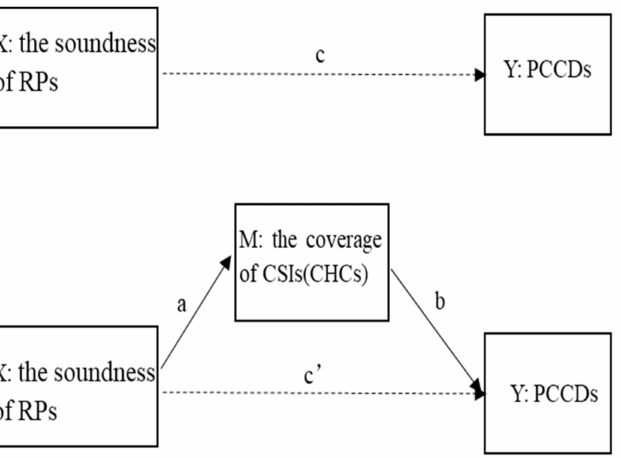
Figure 1. Mediating model for this study’s conceptual framework. Abbreviations: RPs, regulatory policies; CSIs, community service institutions; CHCs, community health centres; PCCDs, prevention and control of chronic